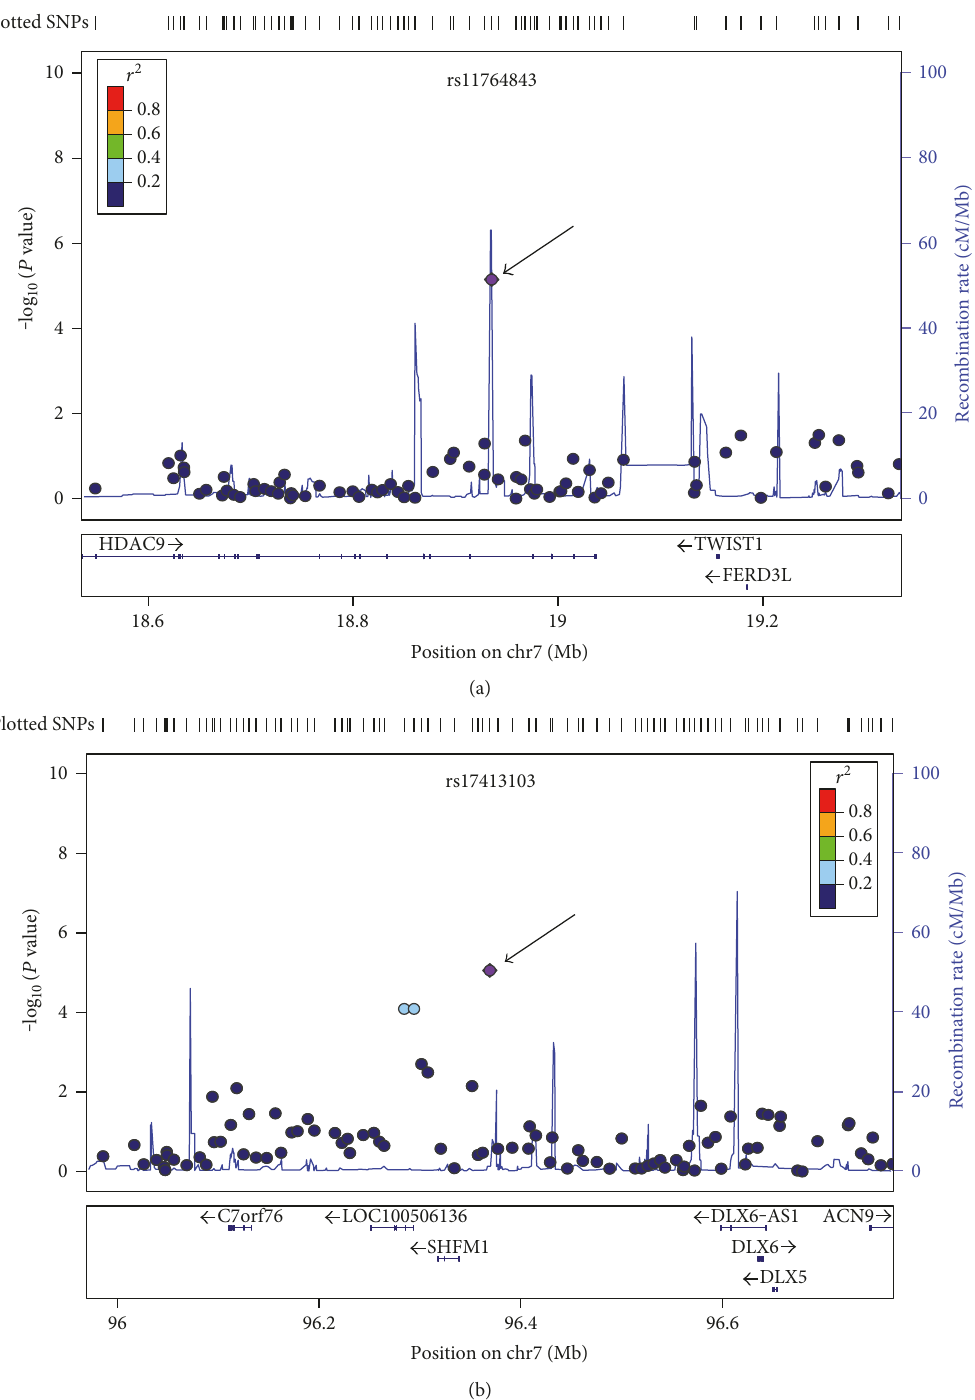
Figure 2: Regional association plots for the lumbar spine BMD in the HDAC9 and SHFM1 chromosomal regions. The x- axis is the physical position on the chromosome (Mb), and the y -axis denotes the association test result as the − log ( P value). SNPs are color-coded according to the linkage disequilibrium (LD) with the lead SNP (purple diamond) indicated by the arrow. (a) The SNP rs11764843 in the HDAC9 region; (b) the SNP rs17413103 in the SHFM1 region. Theregional association plots were generated using LocusZoom and onlyshow genotyped